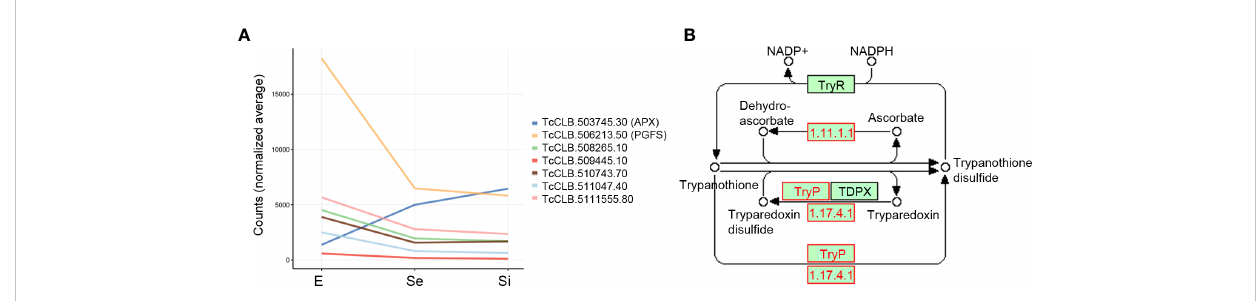
FIGURE 5 Trypanothione metabolism related DEGs of T. cruzi epimastigotes during prolonged cultures. Selected DEGs related to trypanothione metabolism of early and intermediate stationary phase (Se and Si respectively) in comparison to exponentially growing epimastigotes (E) were analyzed. (A) Gene expression of selected DEGs is presented as a spaghetti plot from Se and Si. TcCLB.503745.30: ascorbate peroxidase, TcCLB.506213.50: prostaglandin F synthase reductase, TcCLB.508265.10: glutathione-S-transferase/glutaredoxin, TcCLB.509445.10: tryparedoxin peroxidase, TcCLB.510743.70: lactoylglutathione lyase-like protein glioxilase, TcCLB.511047.40: NADH-cytochrome b5 reductase, TcCLB.511555.80: ribonucleoside-diphosphate reductase small chain. (B) Metabolic chart of the trypanothione reduction pathways indicating the enzymes involved. In red enzymes Ribonucleoside-diphosphate reductase large chain (EC: 1.17.41): TcCLB.506933.20, TcCLB.511555.80, TcCLB.506933.20, TcCLB.511555.80; Tryparedoxin peroxidase (EC:1.11.1.-): TcCLB.509445.10; TcCLB.509445.10; Ascorbate-dependent peroxidase (EC:1.11.1.11):